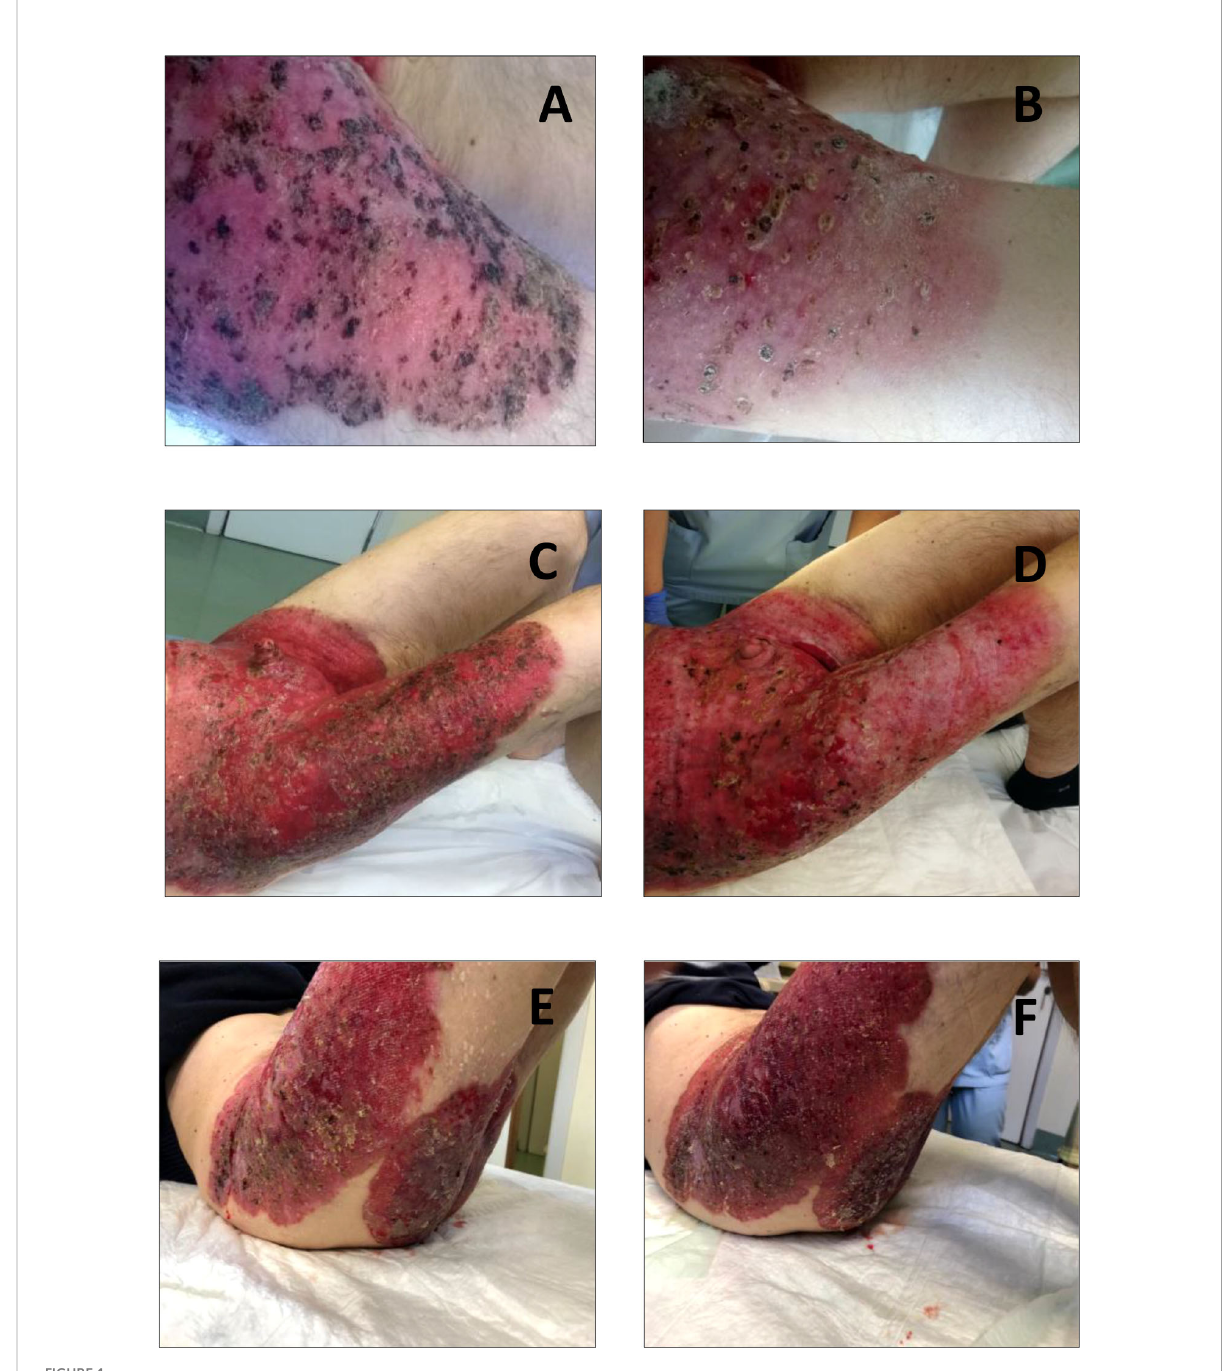
FIGURE 1 Skin scaly and erythematous plaques at different phases of the disease history of our patient. (A) Erythematous lesions with some ulcerated and bleeding areas at diagnosis. (B) Lesions appearing less erythematous and with initial signs of re-epithelization after 4 months of treatment with carboplatin, paclitaxel plus trastuzumab. (C) Clinical disease progression during trastuzumab maintenance therapy. (D) Reduction in bleeding and partial epithelialization of skin lesions after starting vinorelbine plus trastuzumab. (E) Clinical disease progression during vinorelbine plus trastuzumab. (F) Rapid disease progression during anti-androgen therapy plus